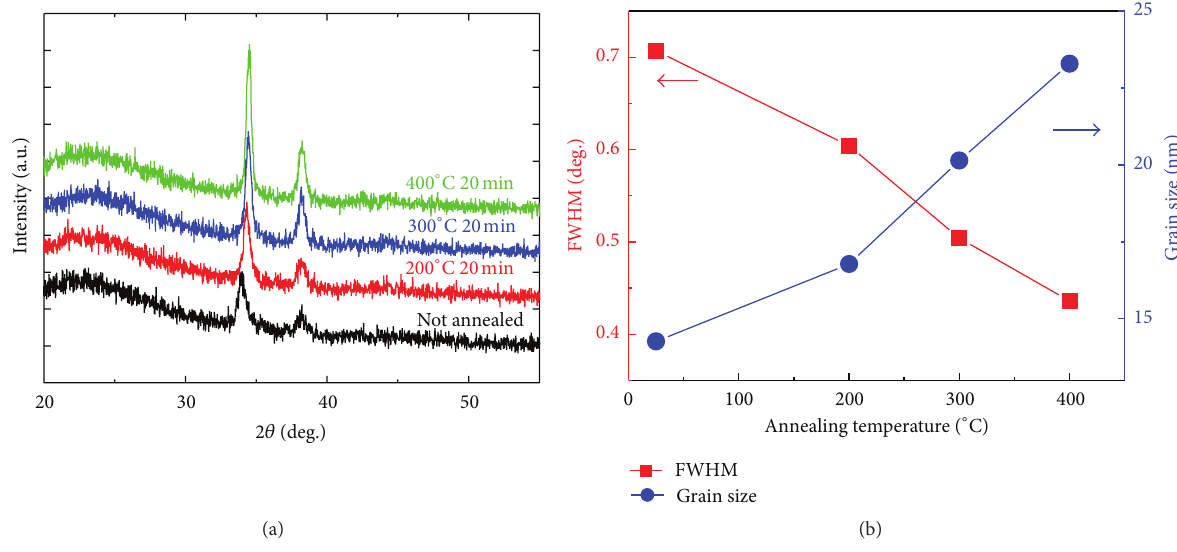
Figure 9: (a) X-ray diffraction spectra and (b) the FWHM of ZnO (0002) and grain size in the ZA(10)Z films as a function of annealing temperature. Table 3: 𝑆/𝑁 ratio responses for each experimental parameter at each level. Experimental